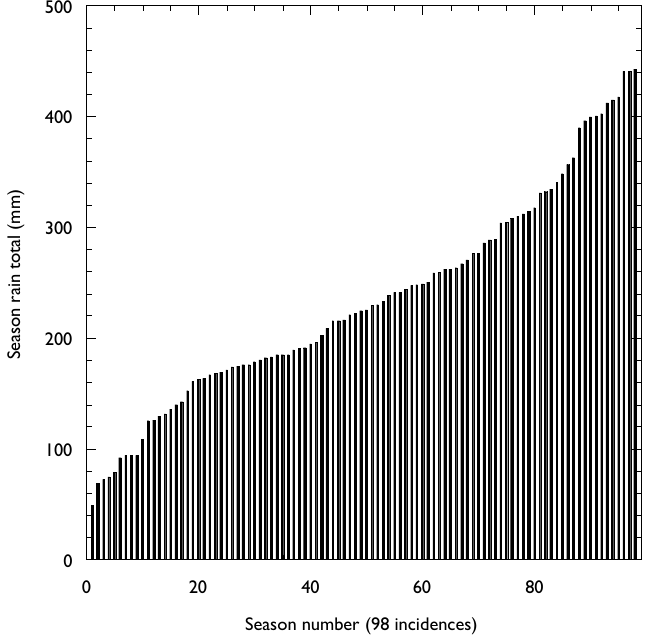
Figure 2. Total rain at Lubbock, TX for a series of seven, 150-day potential cropping periods each year for the 14-year period, 2001 to 2014. Data from historic weather at study-site.